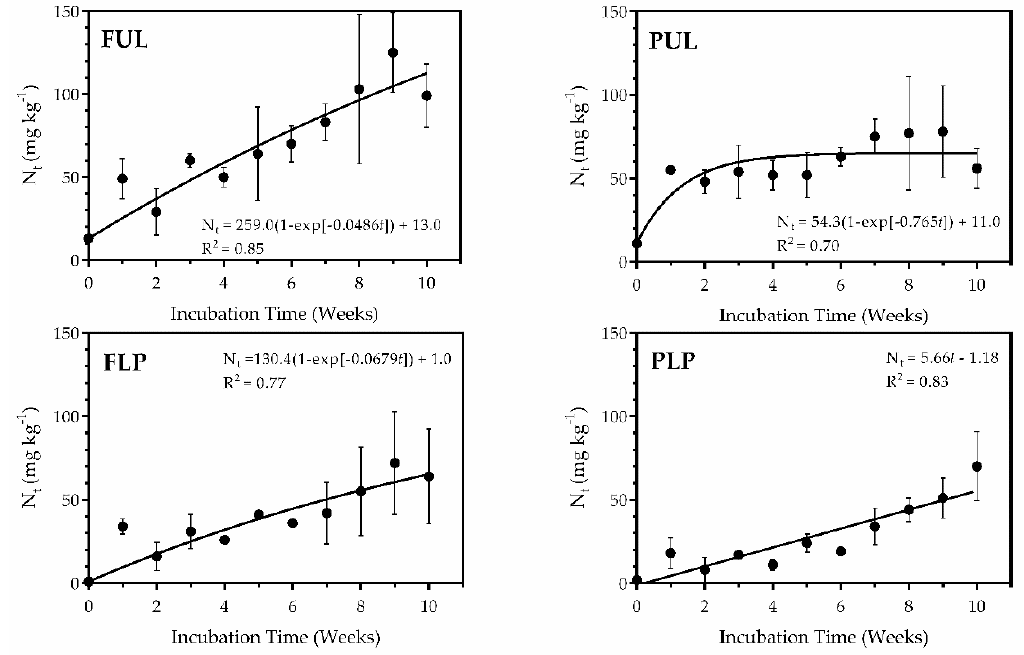
Figure 3. Total inorganic N (Nt = NO 3 -N + NH 4 -N) for four broiler litter materials applied to Norfolk soil: FUL = fine untreated litter; PUL = pelletized untreated litter; FLP = fine low-P treated litter; PLP = pelletized low-P treated litter. Except for PLP the lines are based on first order reaction (Equation). Data are the mean of three samples and error bars are one standard deviation of the mean. Table 6. Weekly soil inorganic N available in percentage of total N added with four poultry litter materials applied on the surface of a Norfolk sandy loam soil. Data are the mean of three samples. Time